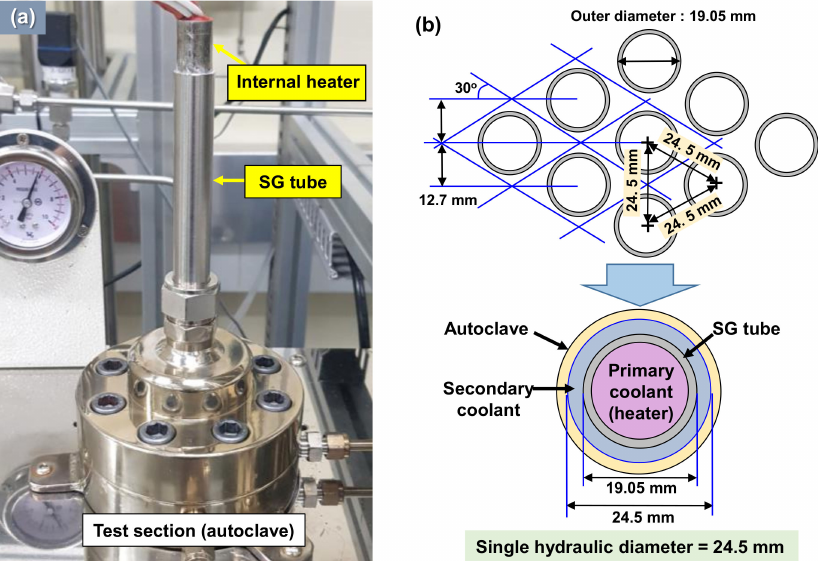
Figure 3. ( a ) Test section and internal heater-mounted SG tube and ( b ) design of test section as the single hydraulic flow